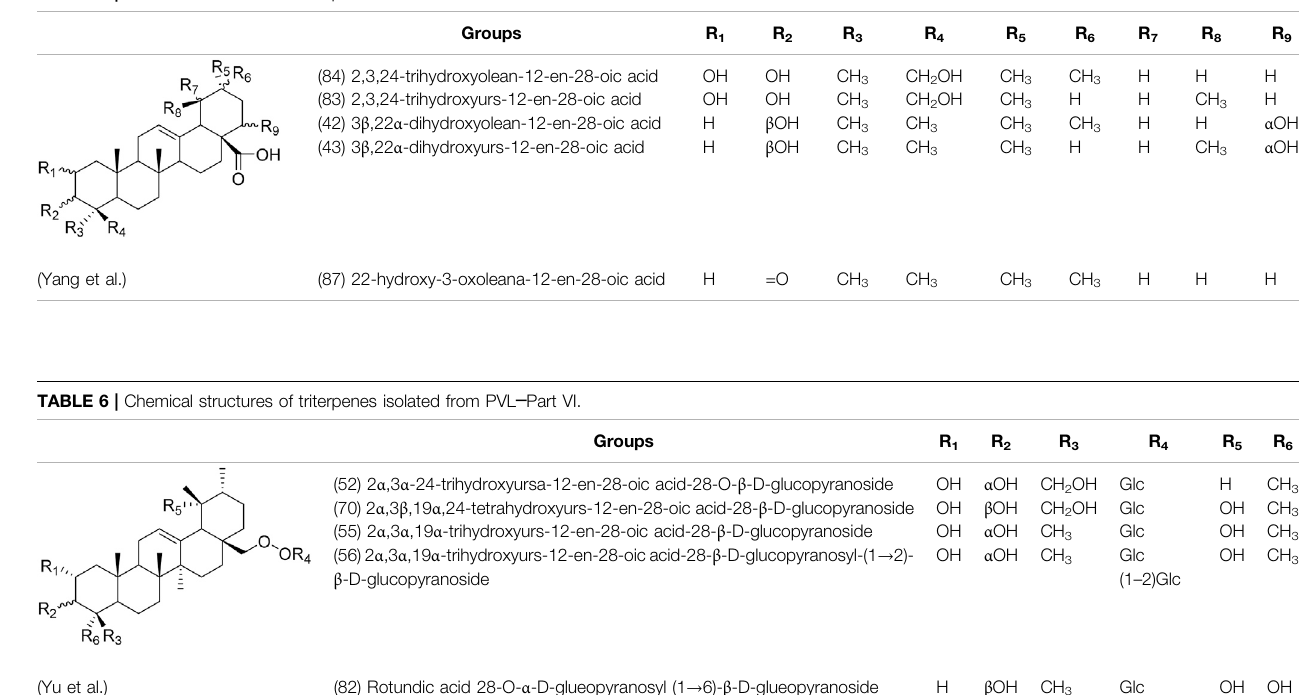
TABLE 5 | Chemical structures of triterpenes isolated from PVL ─ Part V.